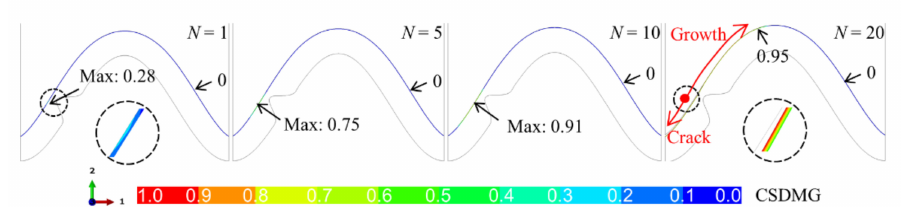
Figure 10. Evolution of damage degradation variable (CSDMG) in the ceramic layer near the interface including one bulge (at room